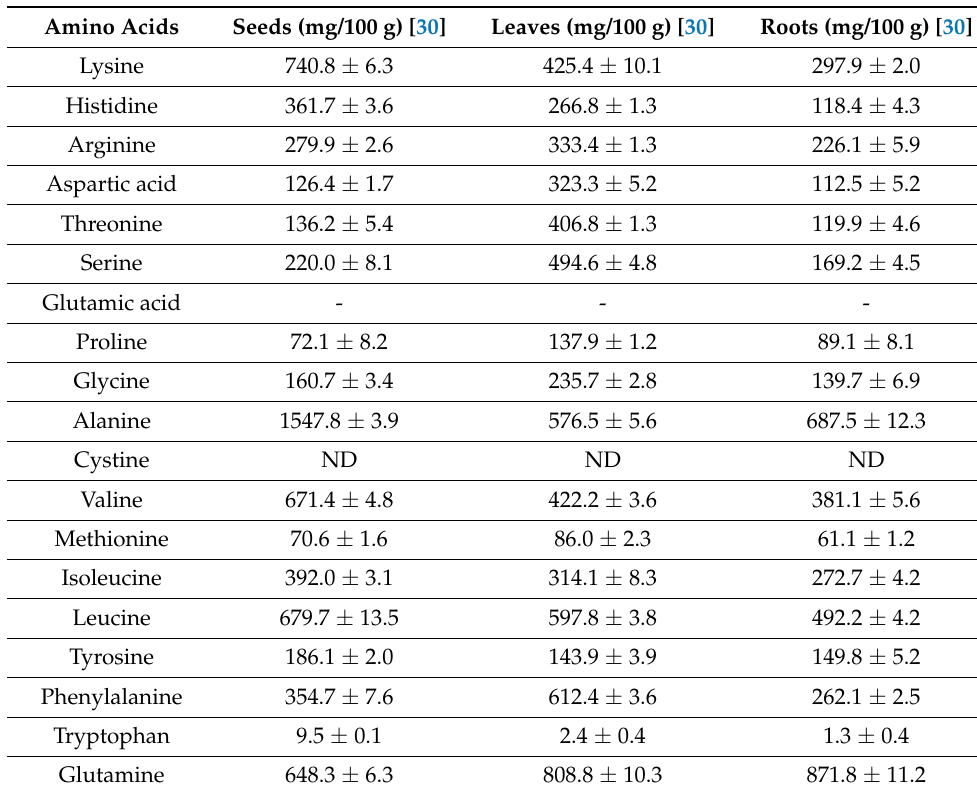
Table 4. Amino acid composition of different parts of Cajanus cajan .